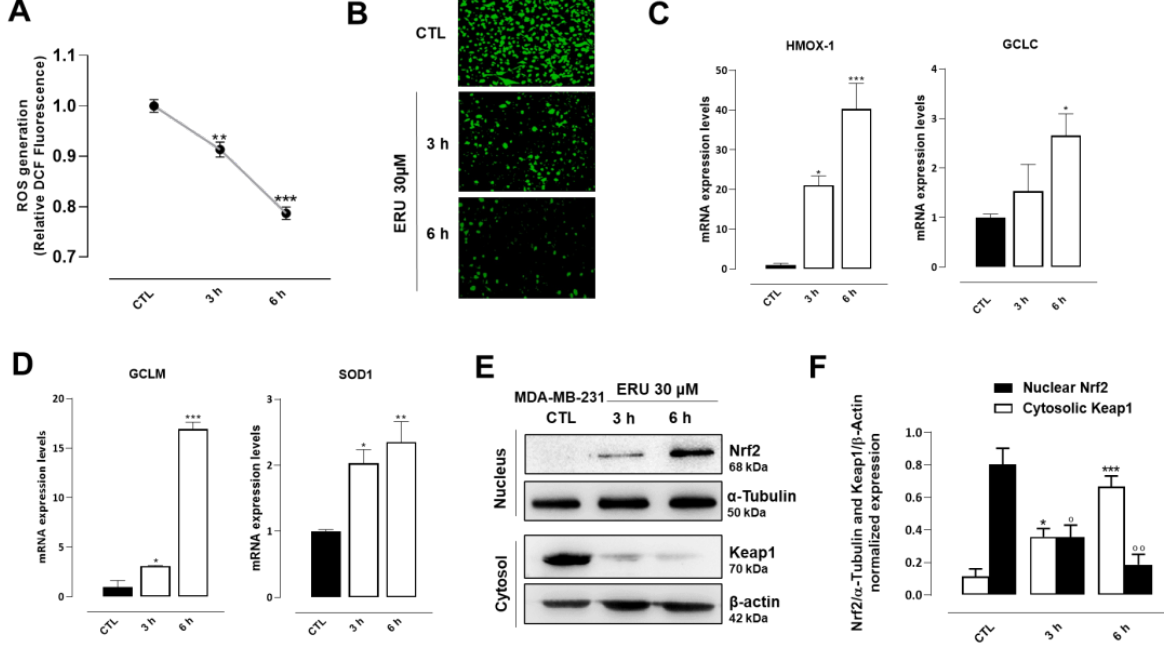
Figure 3. ERU reduces ROS production and promotes the expression of antioxidant enzymes in MDA-MB-231 cells throughout the Nrf2 pathway. ( A ) Intracellular ROS levels in MDA-MB-231 cells treated with Fenton’s reagent (2 mM H 2 O 2 /Fe 2+ ) alone or in presence of ERU (30 µM) for 3 and 6 h. Values are expressed as relative DCF fluorescence intensity normalized to viable cell numbers. ( B ) Representative fluorescence microscopic images of intracellular ROS production by DCF staining (green) in MDA-MB-231 cells. ( C , D ) mRNA expression levels of HMOX-1, GCLC, GCLM, and SOD1 in MDA-MB-231 cells treated with ERU (30 µM) for 3 and 6 h. ( E , F ) Representative blots and relative quantitative analysis of nuclear Nrf2 and cytosolic Keap1 protein expression in MDA-MB-231 cells treated with ERU (30 µM) for 3 and 6 h. α-tubulin and β-actin were detected as a loading control for nucleic and cytosolic portions, respectively. Results are shown as mean ± SEM of three independent experiments ( n = 3). * p < 0.05, ** p < 0.01, *** p < 0.001, vs. CTL; ° p < 0.05, °° p < 0.01, vs. nuclear CTL 2.4. Erucin Inhibits Cell Motility, Invasion, and Colony Formation of Human TNBC Cells In the expriment’s final stage, we evaluated the potential antimetastatic activity of erucin in MDA-MB-231 cells performing wound healing and cell invasion assays. Erucin 0.3 and 1 µM concentrations (selected for not interfering with cell proliferation and apop- tosis) prevented migration and invasiveness of MDA-MB-231 cells compared to control vehicle-treated cells (Figures 4A,B and 5A,B). Additionally, erucin significantly decreased colony formation ability, reducing both their number and diameter (Figures 4A,B and 5A,B).